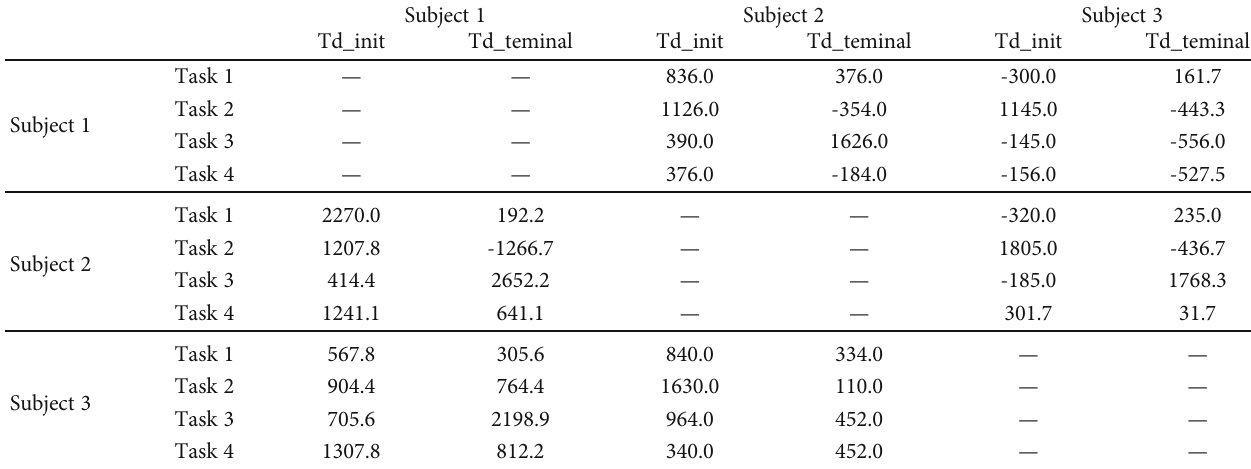
Table 6: The initial and terminal transition time latency.